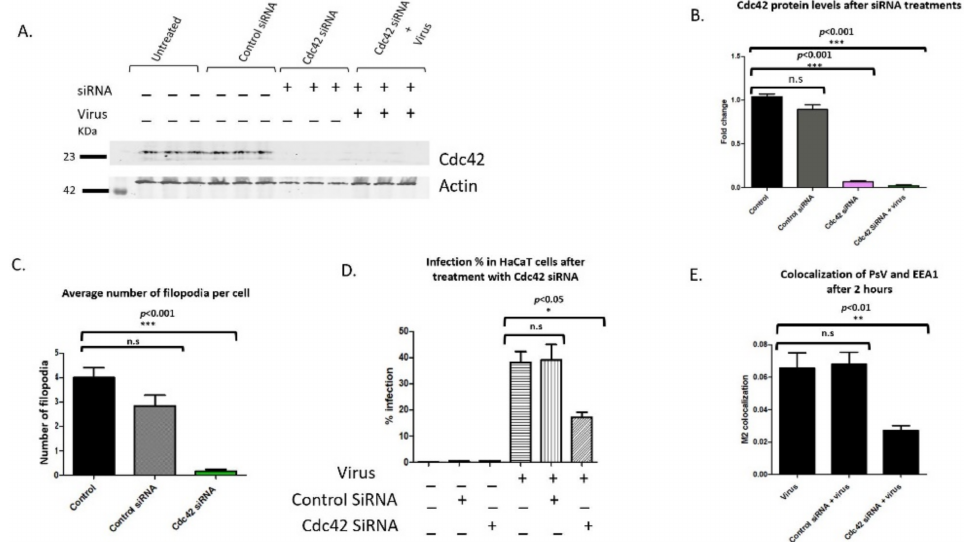
Figure 8. siRNA mediated knockdown of Cdc42 results in a significant decrease in infection and internalization. Cc42 protein levels were knocked down with siRNA. Cells were treated with control siRNA and Cdc42 siRNA for 48 h. ( A ) Western blot analysis of siRNA knockdown using Cdc42 and actin antibodies. Cells were incubated with virus on ice for 2 h and unbound virus was washed from wells. Cdc42 protein levels were normalized with actin. ( B ) Densitometry of western blot showing a significant decrease in Cdc42 protein levels after 48 h even with the addition of virus (samples compared to control with no siRNA or virus, n = 3, ***, p < 0.001). ( C ). Average number of filopodia per cell after siRNA treatments. Filopodia were counted along the cell periphery with FiloQuant image J plugin, single image analysis. Statistical significance was determined by Dunnett’s multiple comparison test (compared samples to control cells not treated with universal or Cdc42 siRNA, n = 50, ***, p < 0.001). ( D ) Flow cytometry was performed on cells transfected with control and Cdc42 siRNA. Graph of infection percentages in HaCaT cells treated with control siRNA, Cdc42 siRNA, and virus. Statistical differences were determined by Dunnett’s multiple comparison test (samples compared to control infection, n = 9, *, p < 0.05). ( E ) Graph representation of colocalization between PsV and EEA1 after 2 h of viral addition for three independent experiments. Statistical difference was determined by unpaired two-tailed t -test ( n = 6, **, p < 0.01). Average was displayed with